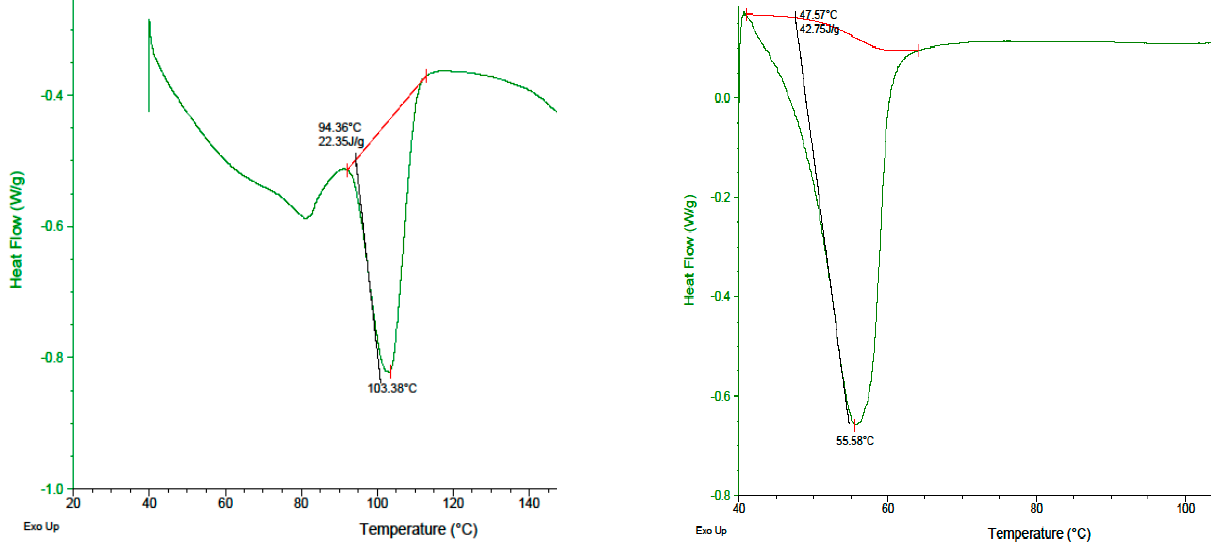
Figure 3. DSC thermograms of AKH and proliposomal formulation (F8).